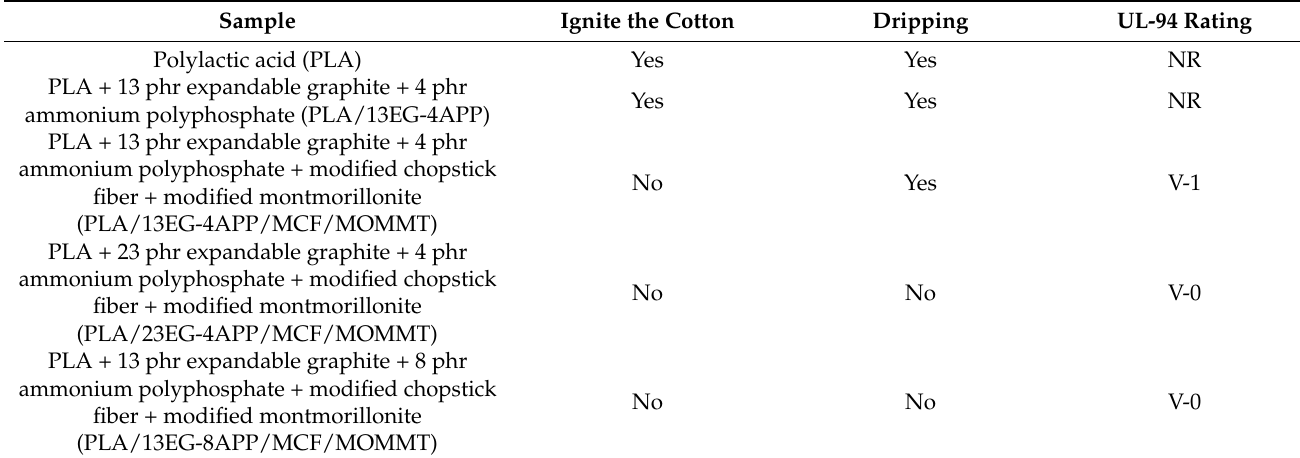
Table 10. Flame retardance properties of PLA and PLA